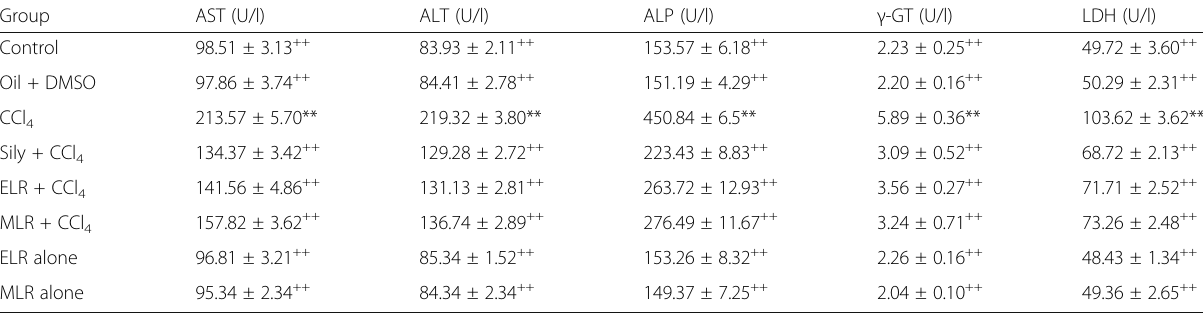
Table 1 Effects of various fractions of R. hastatus leaves on liver function tests Group AST (U/l) ALT (U/l)